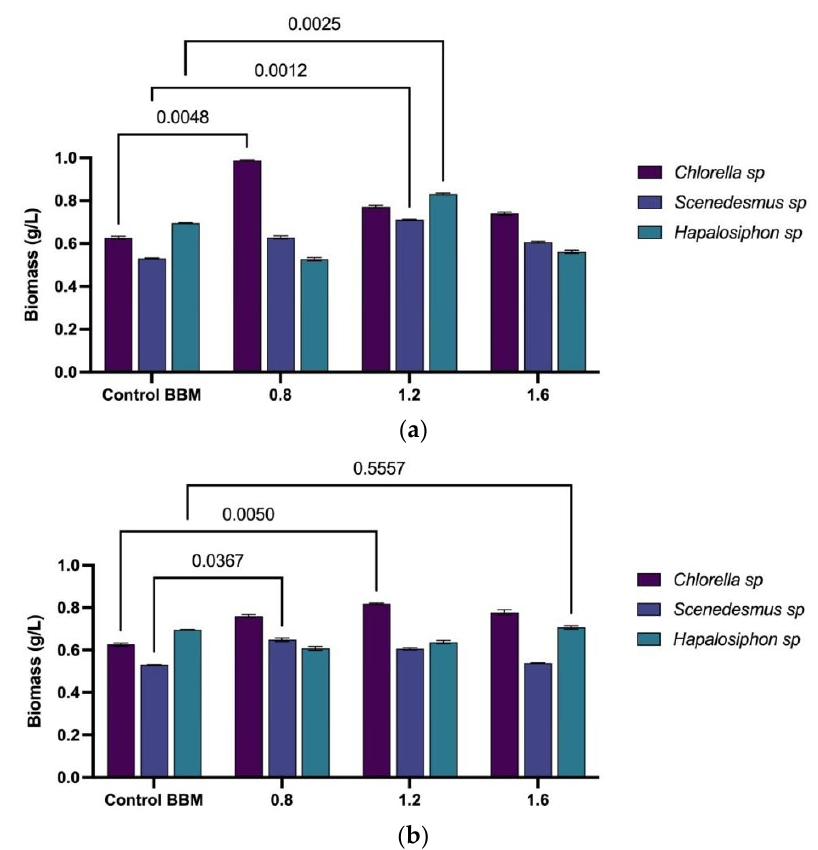
Figure 3. Effect of different concentrations of Na 2 CO 3 ( a ) and NaHCO 3 ( b ) in the biomass concen- tration of the three strains evaluated.